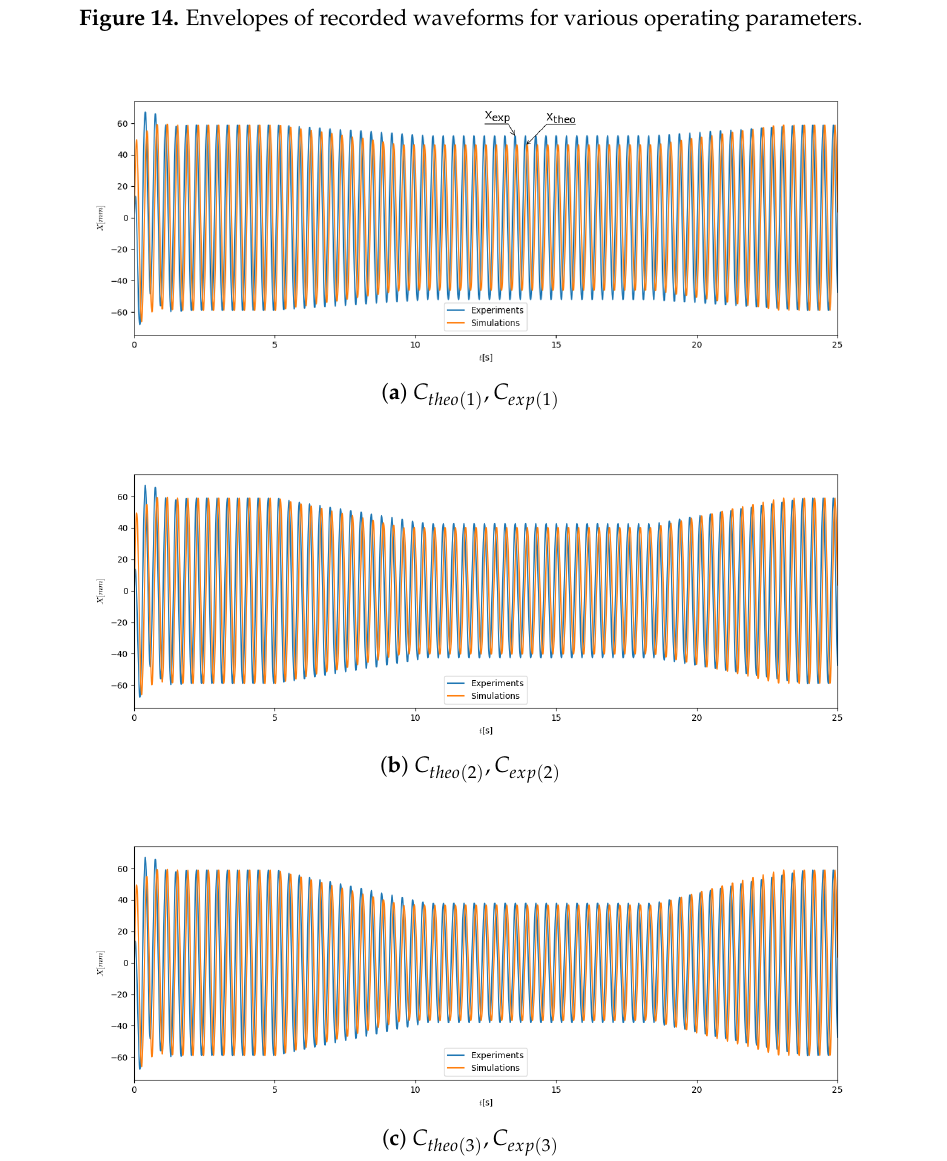
Figure 15. Waveforms for various values of the container volume: ( a ) 0.35 [dm 3 ]; ( b ) 0.50 [dm 3 ]; ( c ) 0.65 [dm 3